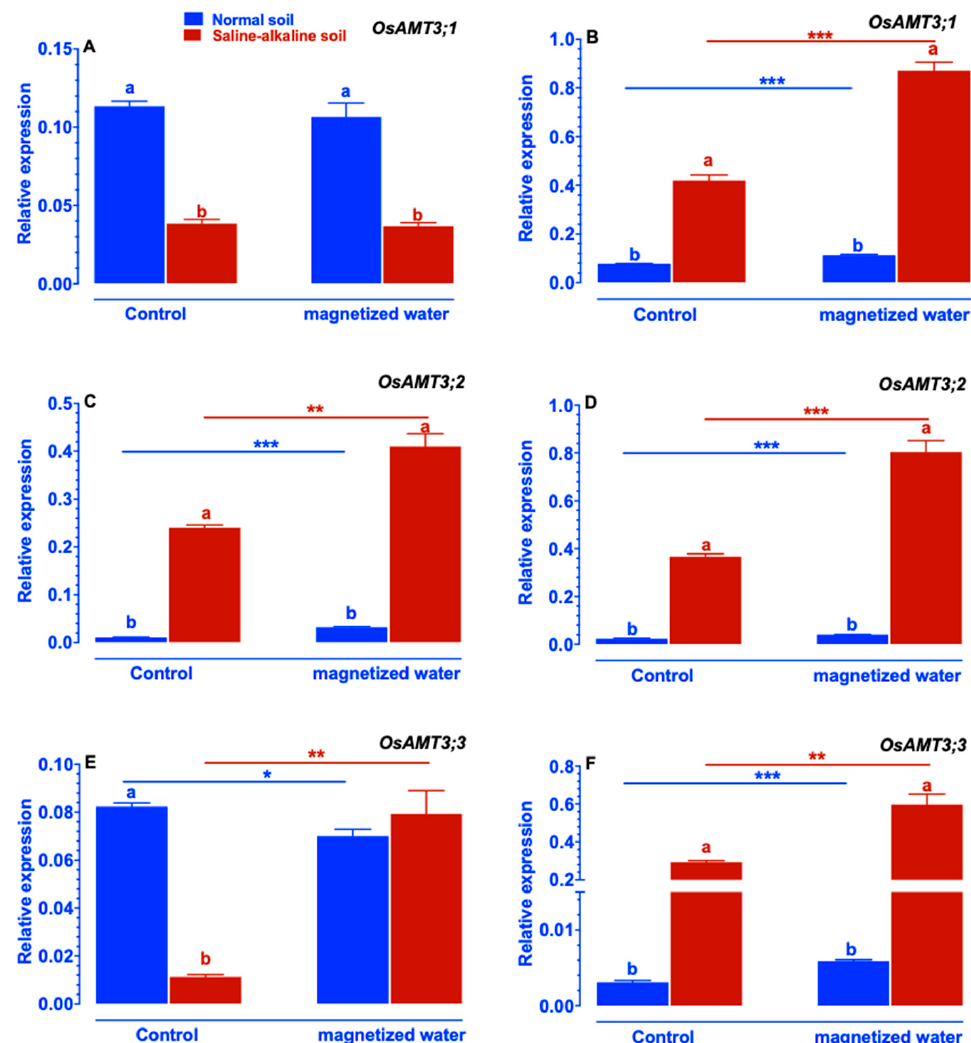
Figure 8. Effects of magnetized water on the expression of the OsAMT3 gene family in Nipponbare seedlings grown in normal and saline–alkaline stress soil: ( A ) OsAMT3;1 in shoot, ( B ) OsAMT3;1 in root, ( C ) OsAMT3;2 in shoot, ( D ) OsAMT3;2 in root, ( E ) OsAMT3;3 in shoot, ( F ) OsAMT3;3 in root. Treatments were as described in Figure 1. Means with different letters are significantly different ( p < 0.05) within the same treatment. Asterisks indicate significant differences between control and saline–alkaline stress of the same genotype, as determined by Student’s t -test (* p < 0.05, ** p < 0.01, *** p <